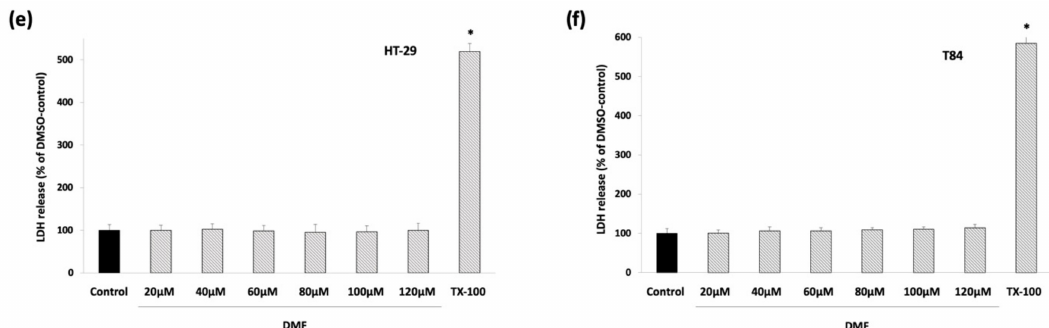
Figure 2. DMF suppresses colon carcinoma cell proliferation but does not display cytotoxic e ff ects. ( a , b ) proliferation assay: HT-29 and T84 were treated for 24 h with the indicated concentrations of DMF. Dimethylsulfoxide (DMSO) 0.2% solvent served as control; ( c , d ) proliferation assay: HT-29 and T84 were treated with 100 µ M DMF for the indicated time. DMSO 0.2% solvent served as control; ( e , f ) cytotoxicity-assay: HT-29 and T84 were treated for 24 h with the indicated concentrations of DMF. DMSO 0.2% solvent served as negative control, Triton X as a positive control. Mean values from at least three independent experiments are shown as mean ± SD. * p < 0.05: significant.